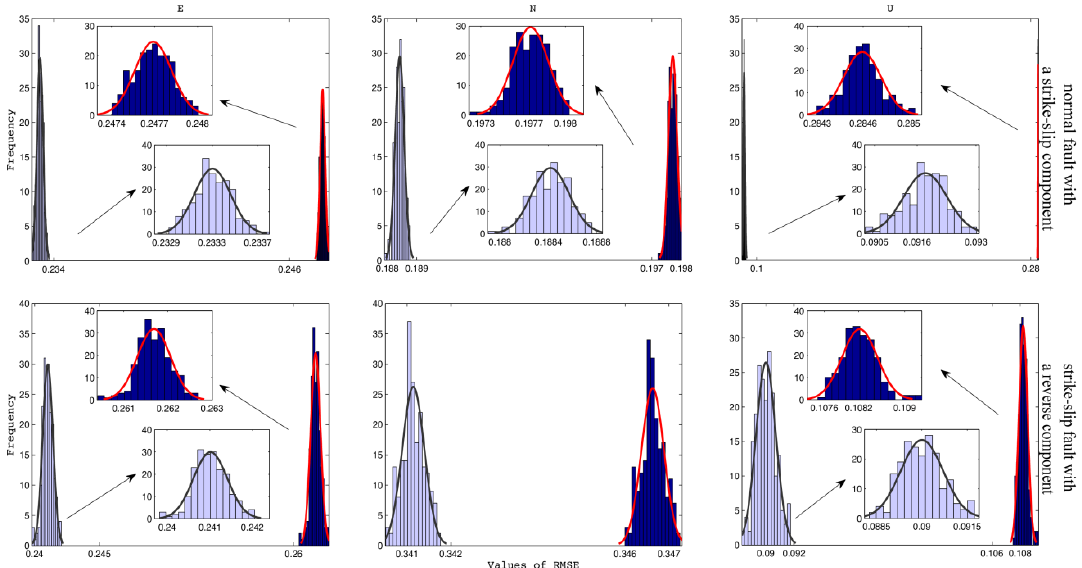
Figure 6. Root mean square error (RMSE) values with a normal density curve histogram under nine global positioning system (GPS) points for Scheme 2.